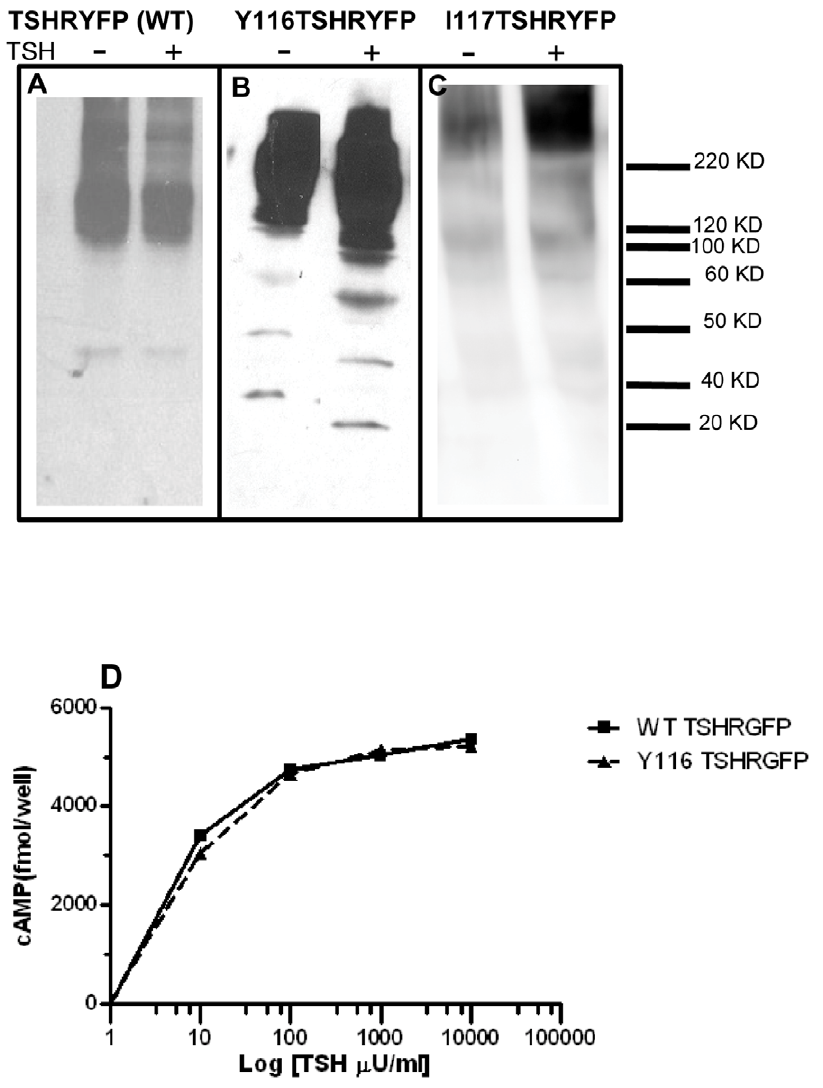
Figure 7. Effect of Y116 mutation on receptor degradation. Panels (A, B and C) Solubilized receptors separated under non-reduced conditions from TSHRYFP (WT), Y116 and I117 mutated receptor transfected cells at 0 and 30 minutes after 1000 m U/ml of bovine TSH. The Y116 mutated receptors showed enhanced degraded forms of 60KD to 20KD which was not observed with the wild type receptor nor I117 mutated receptors. Panel D : HEK 293 cells transfected with the WT receptor (TSHRYFP) and Y116 mutated receptor where stimulated with varying doses of bovine TSH. A dose-dependent cAMP response of the two receptors is shown in the graph. Y116 mutation on ectodomain had no effect on the response of receptors to